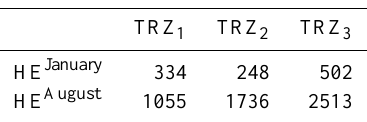
Daily HE in January and in August in the TRZ i ( i = 1 , 2 , 3).